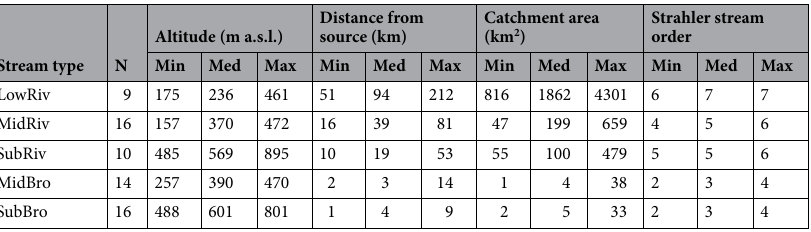
Table 1. Basic characteristics of the 65 stream sites classified into five types along a river continuum: low altitude rivers (LowRiv), mid-altitude rivers (MidRiv), submontane rivers (SubRiv), mid-altitude brooks (MidBro), and submontane brooks